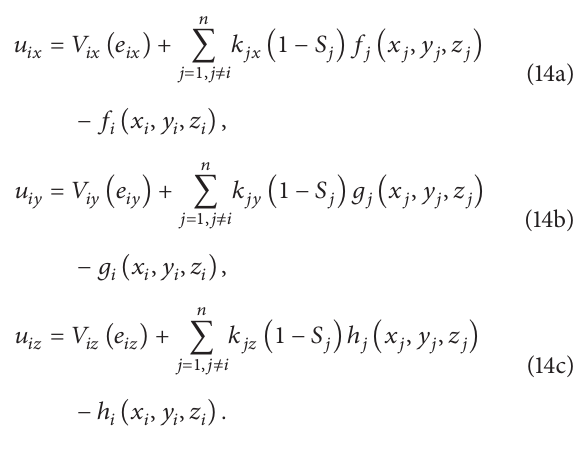
It should be noted that the terms 𝑘 𝑗𝑥 (1 − 𝑆 𝑗 )𝑆 𝑗 𝑢 𝑗𝑥 , 𝑘 𝑗𝑦 (1 − )𝑆 𝑢 𝑆 𝑗 𝑗 𝑗𝑦 , and or